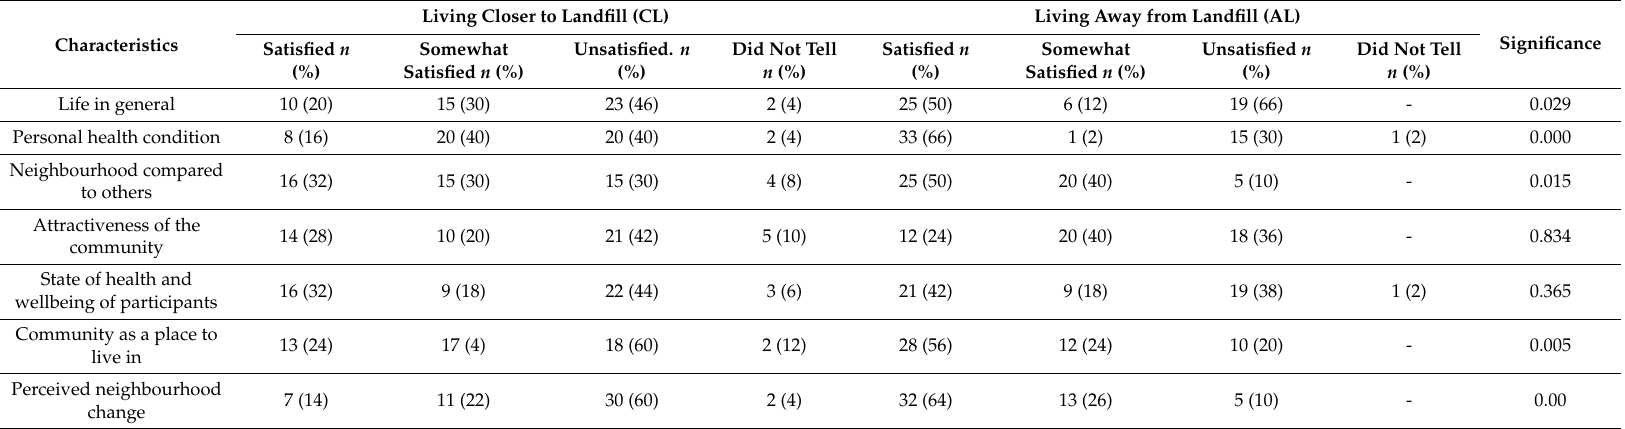
Table 5. Respondents’ ratings of how disturbing the external characteristics are as observed by the participants living in both communities.